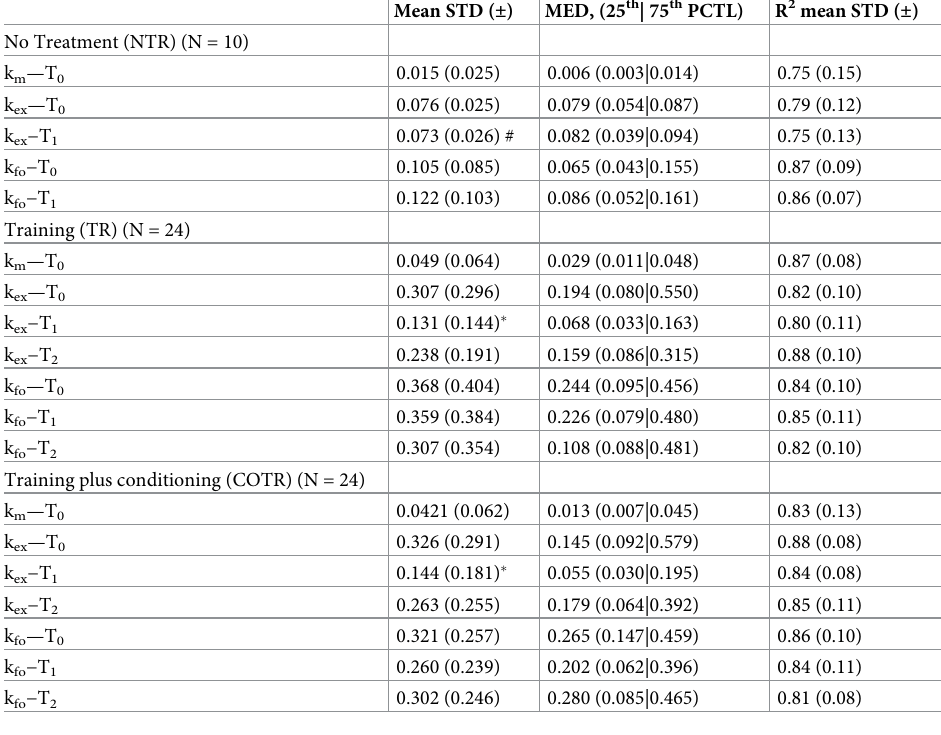
Table 3. DD constants (k) of money (m), exercise (ex), and food